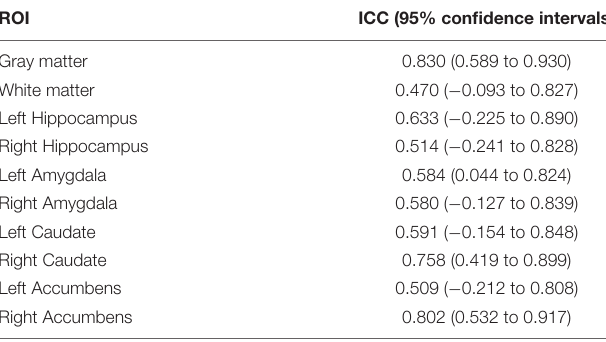
TABLE 4 | Comparison of estimated cerebral blood flow (CBF) values obtained with a pseudo-continuous ASL (pCASL) sequence to those obtained with a pulsed ASL (PASL) sequence at the Skyra MRI system. ICC (95% confidence